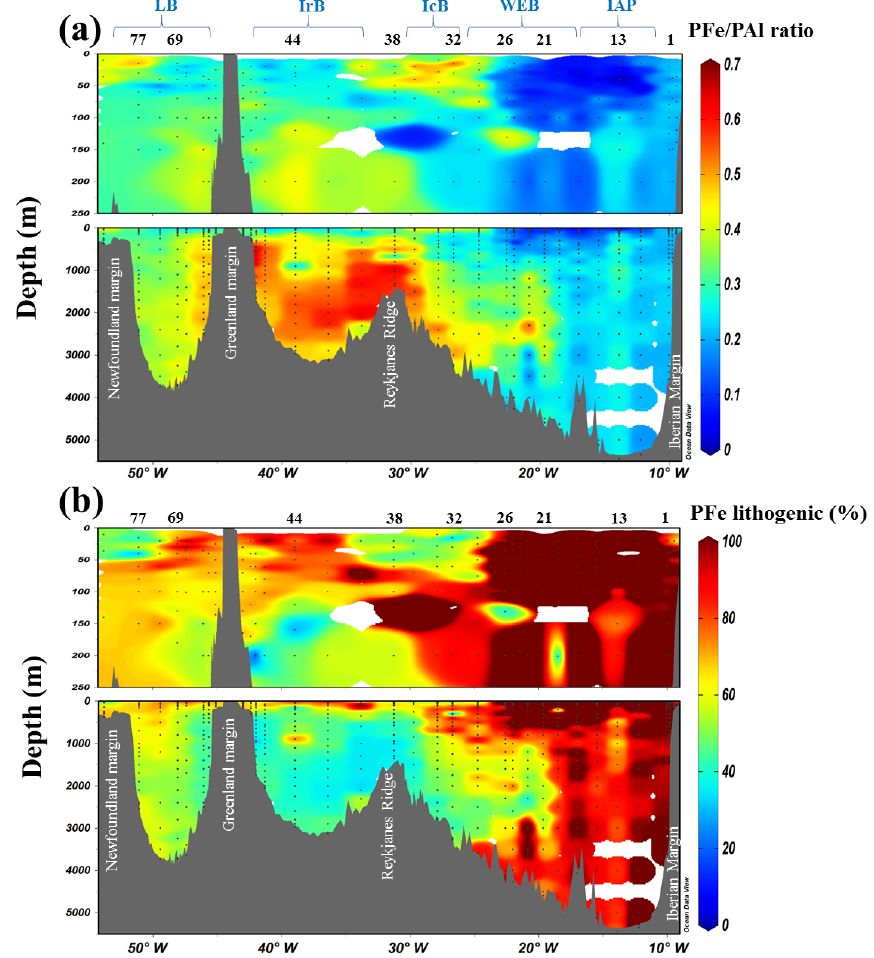
Figure 6. (a) Section of the PFe to PAl molar ratio (molmol − 1 ) during the GEOVIDE cruise (GA01) and (b) contribution (%) of lithogenic particulate iron (PFe litho ) based on Eq. (1). Station IDs and biogeochemical provinces are indicated above each section in black numbers and blue letters, respectively. This figure was generated using Ocean Data View (Schlitzer, R., Ocean Data View, http://odv.awi.de/,